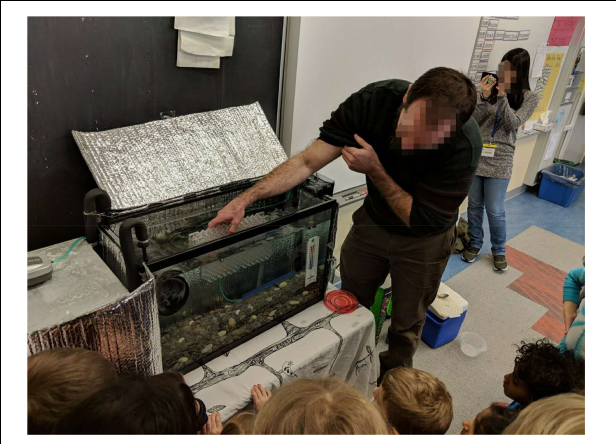
FIGURE 4 | Setting up Salmon tank in grade 2 classroom.